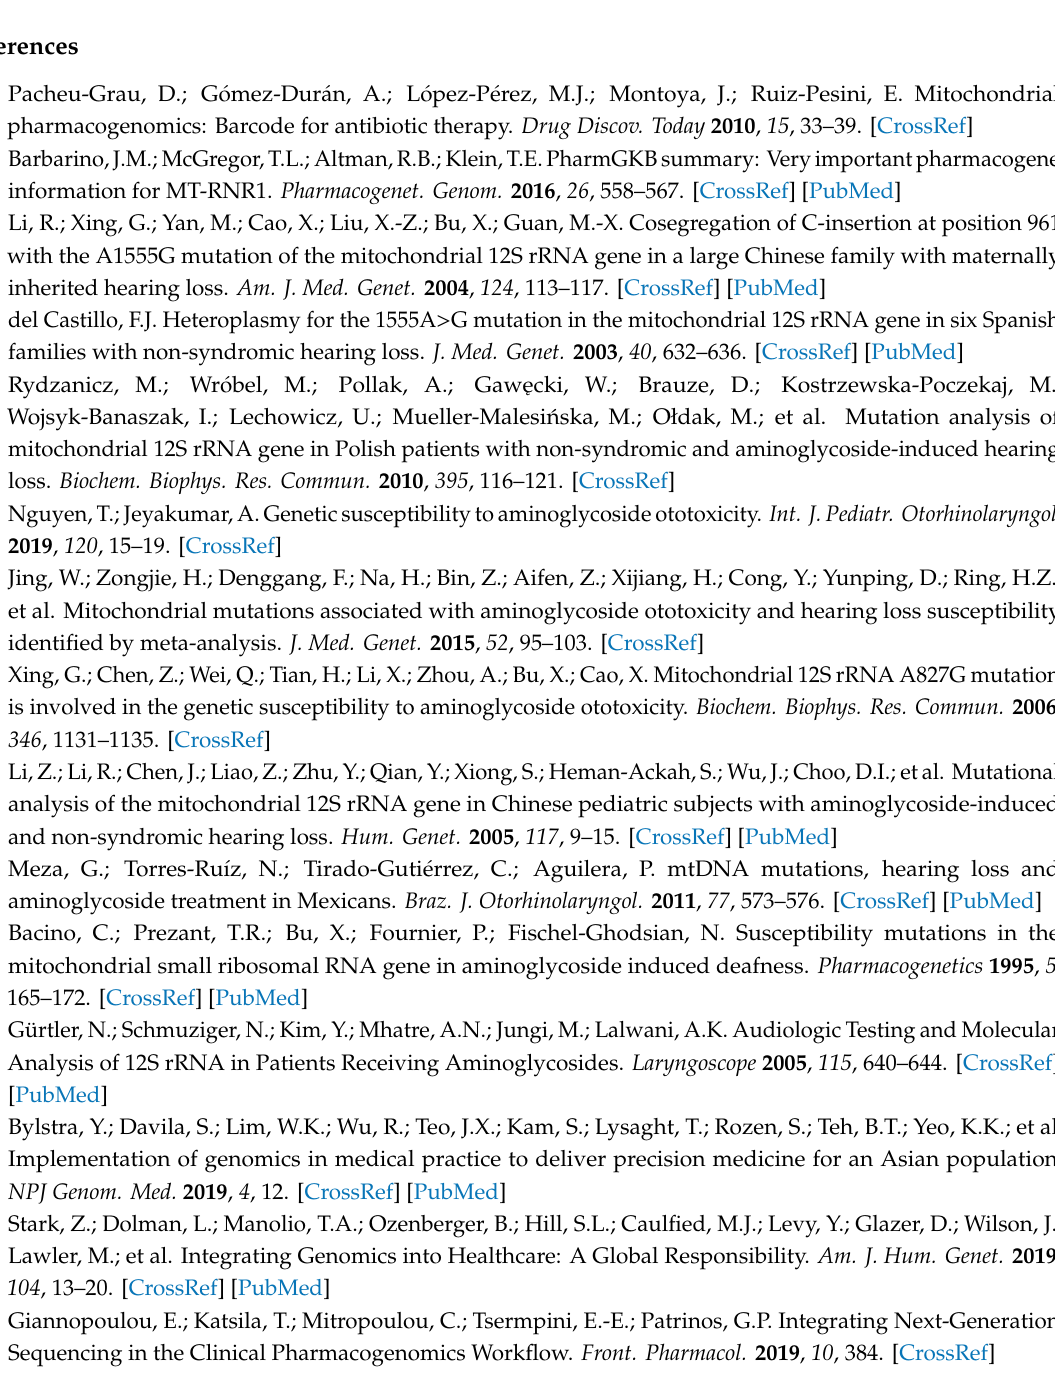
and NGS metrics, Table S3: MT-RNR1 variants identified in 1245 Clinical WES samples using mtDNA o ff -target NGS